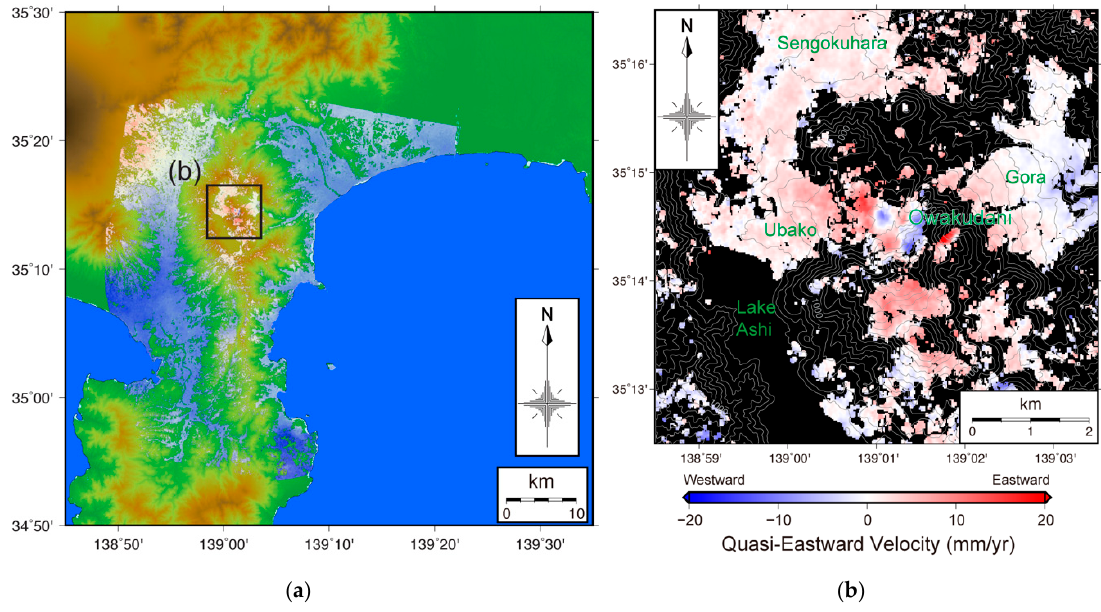
Figure 7. Distribution of quasi-eastward velocity over the ( a ) entire region; ( b ) area of interest shown in the black rectangle (inset) in ( a ). The base map of ( a ) is a topographical map based on 10 m mesh height data released by the GSI, and its color scale is the same as Figure 1. Intervals of contour lines in ( b ) are 50 m in height.